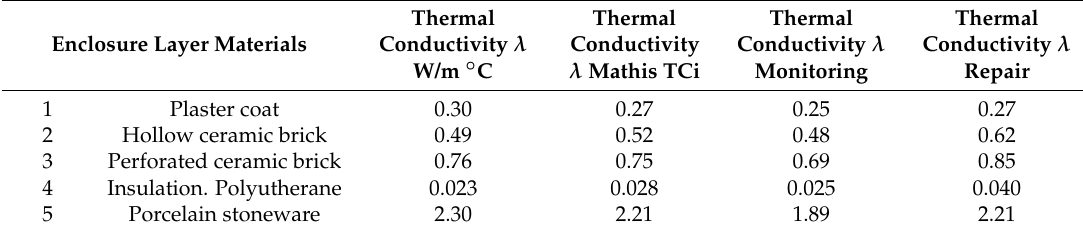
Table 7. Results of U-value across different scenarios.